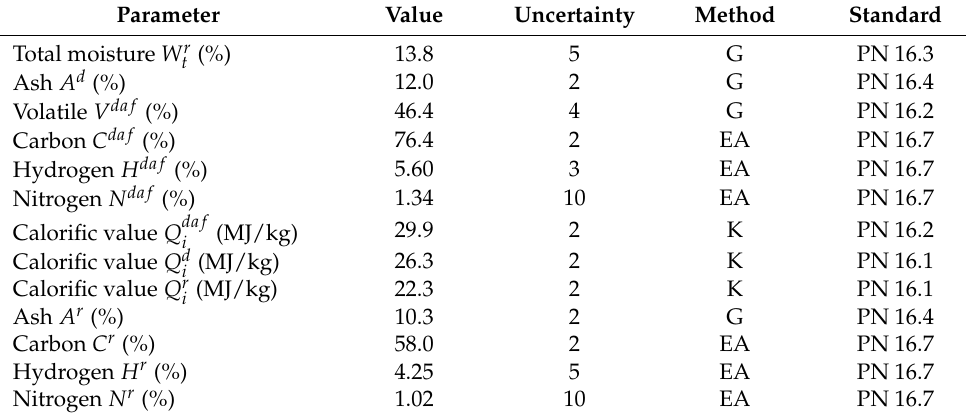
Table 1. The analysis of the coal with the help of Slovak testing standards used by an accredited